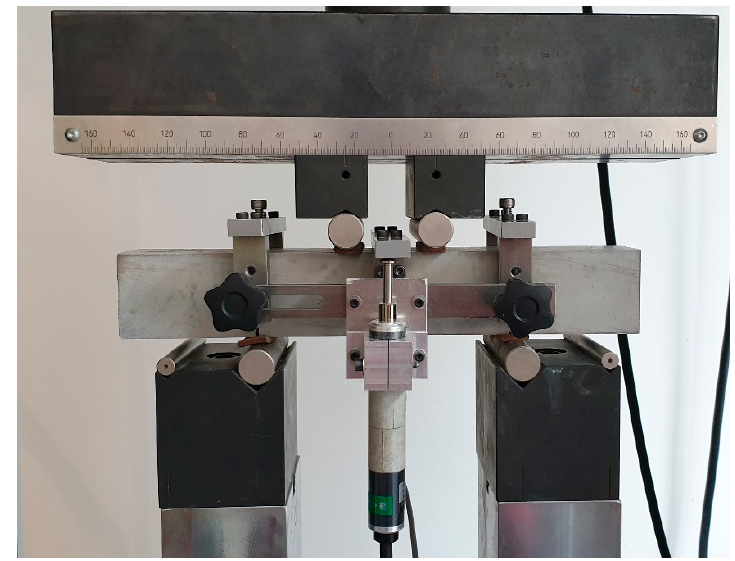
Figure 3. Four-point bending test performed according to ASTM C1609 [52].